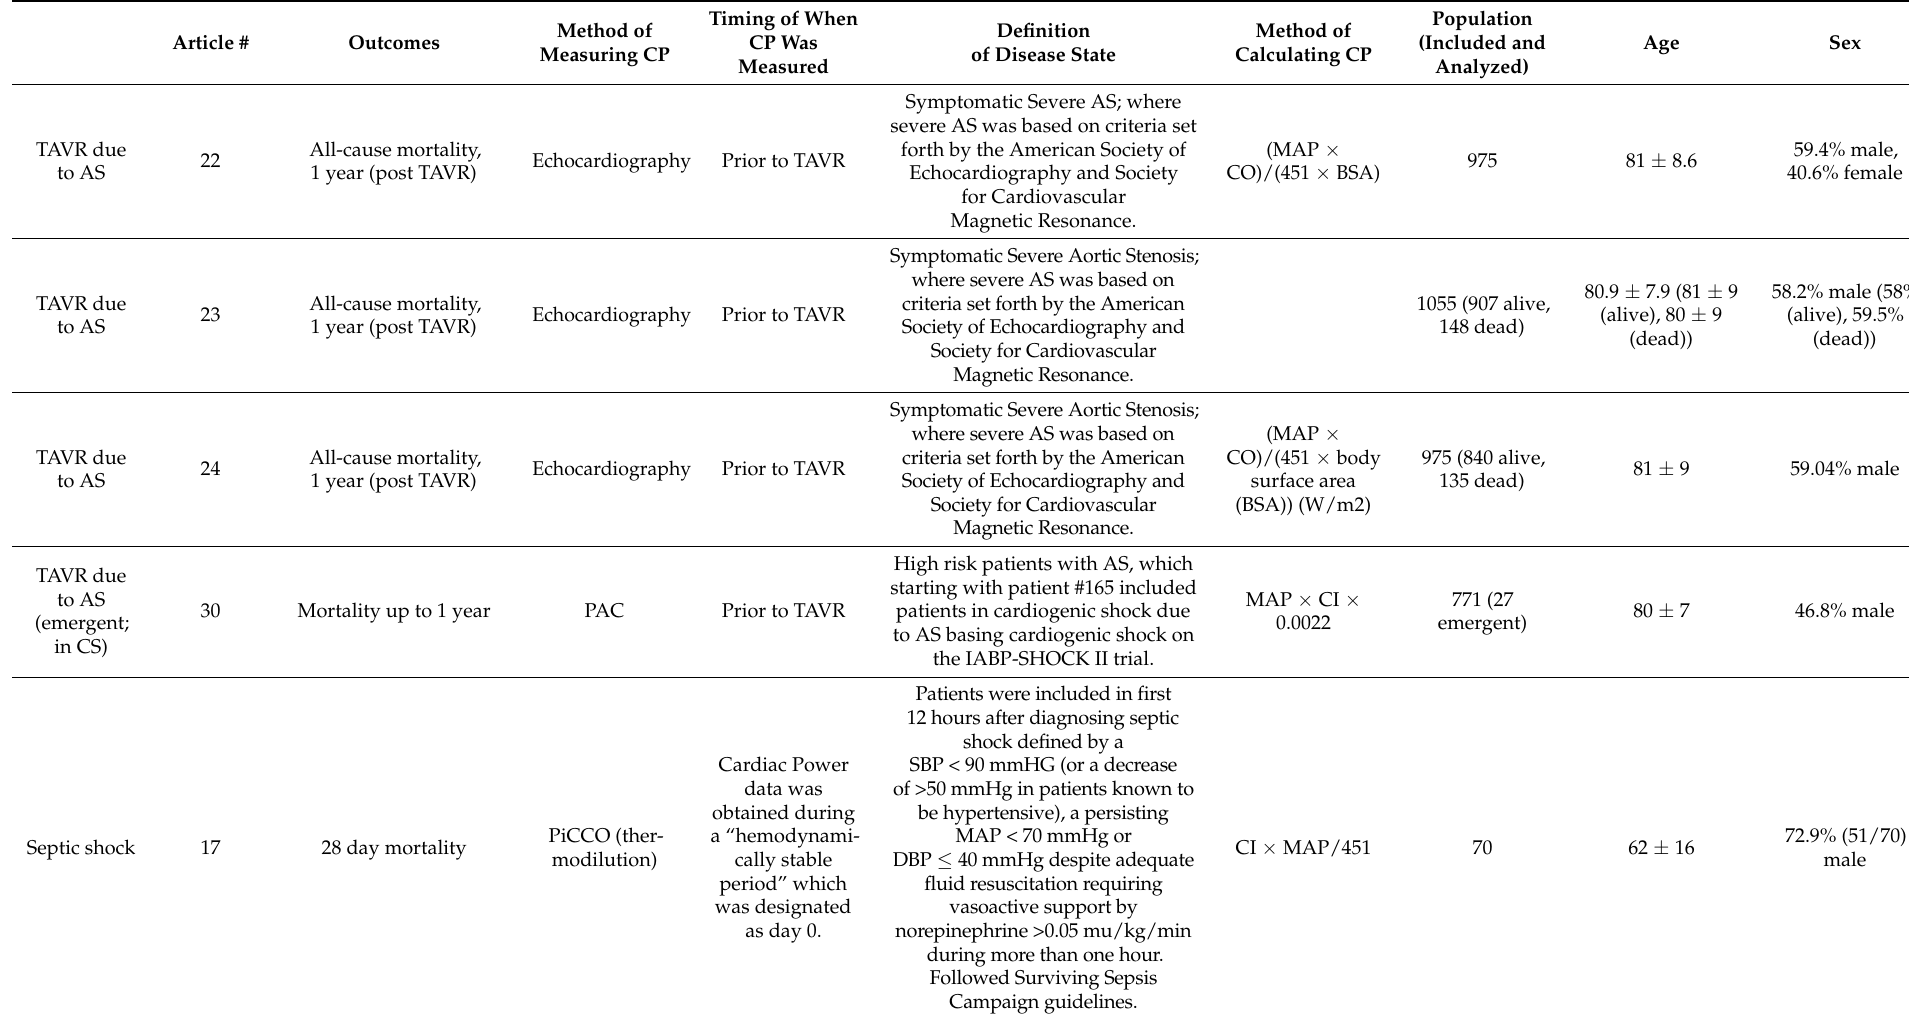
Table 3. Detailed Journal Article Demographics, Outcomes and Disease State Definition. Condition